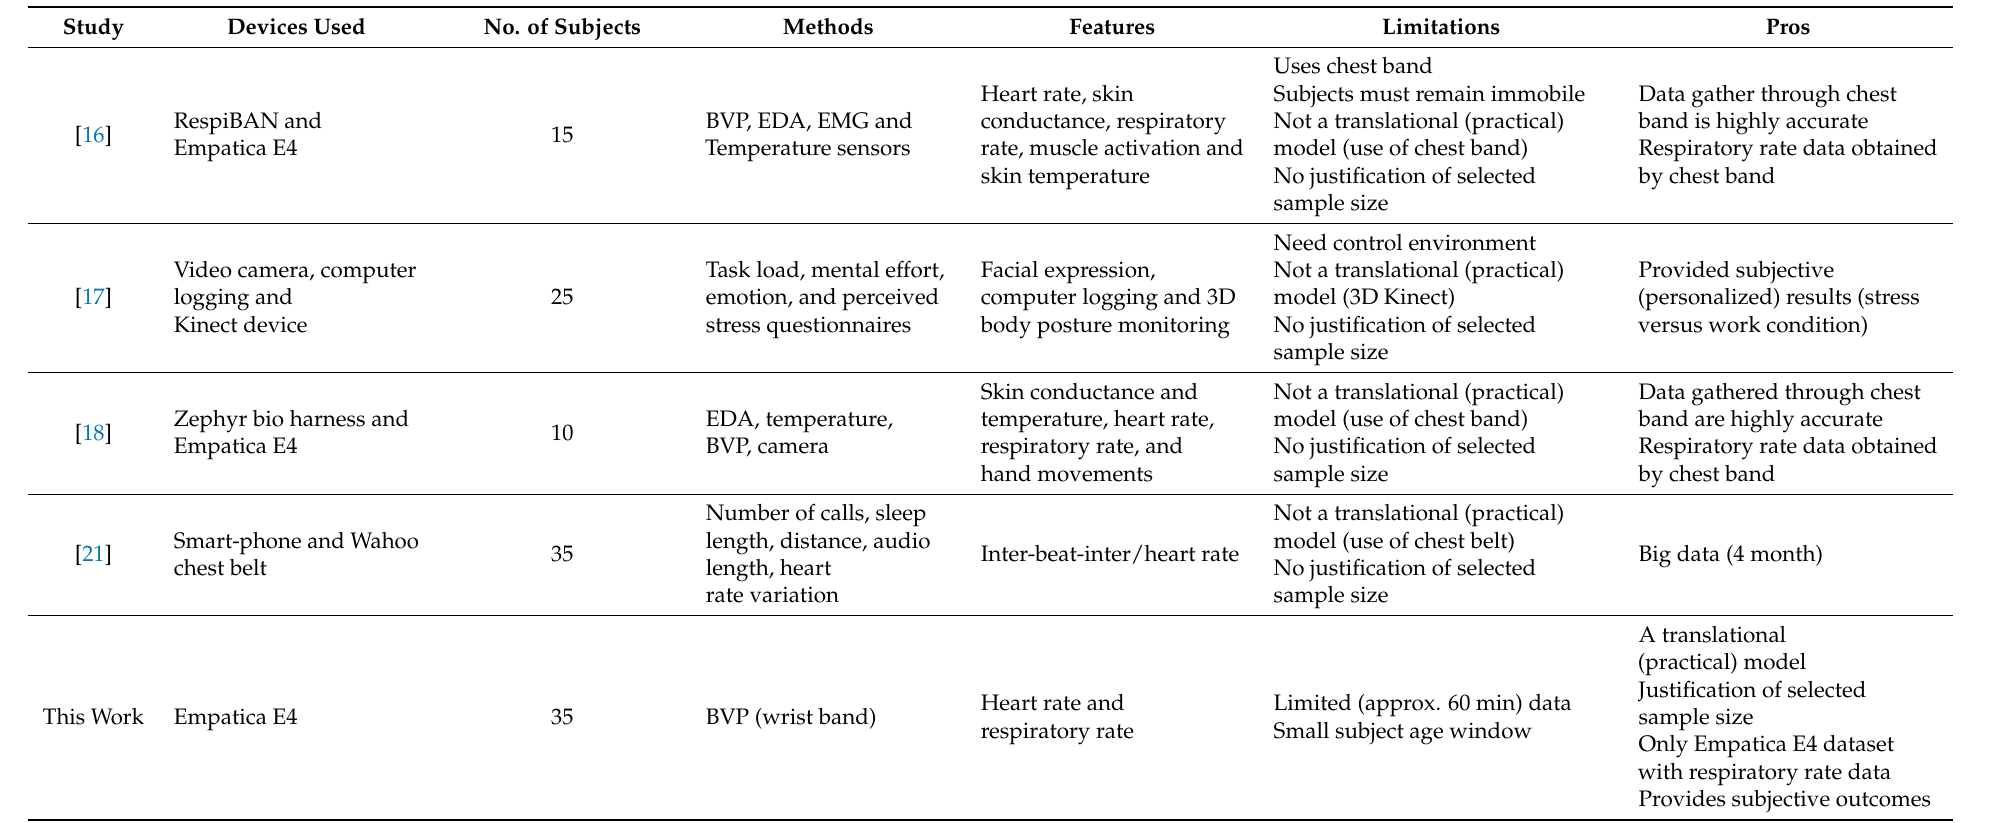
Table 7. Summary: Comparison of Proposed Dataset with Existing State-Of-The-Art